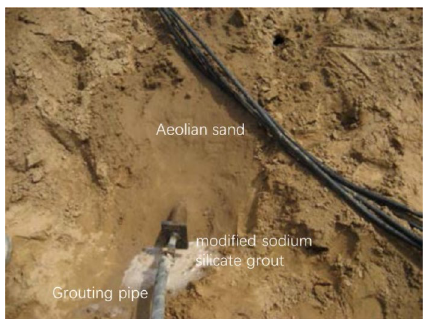
Figure 7. In-situ test of modified sodium silicate grout.